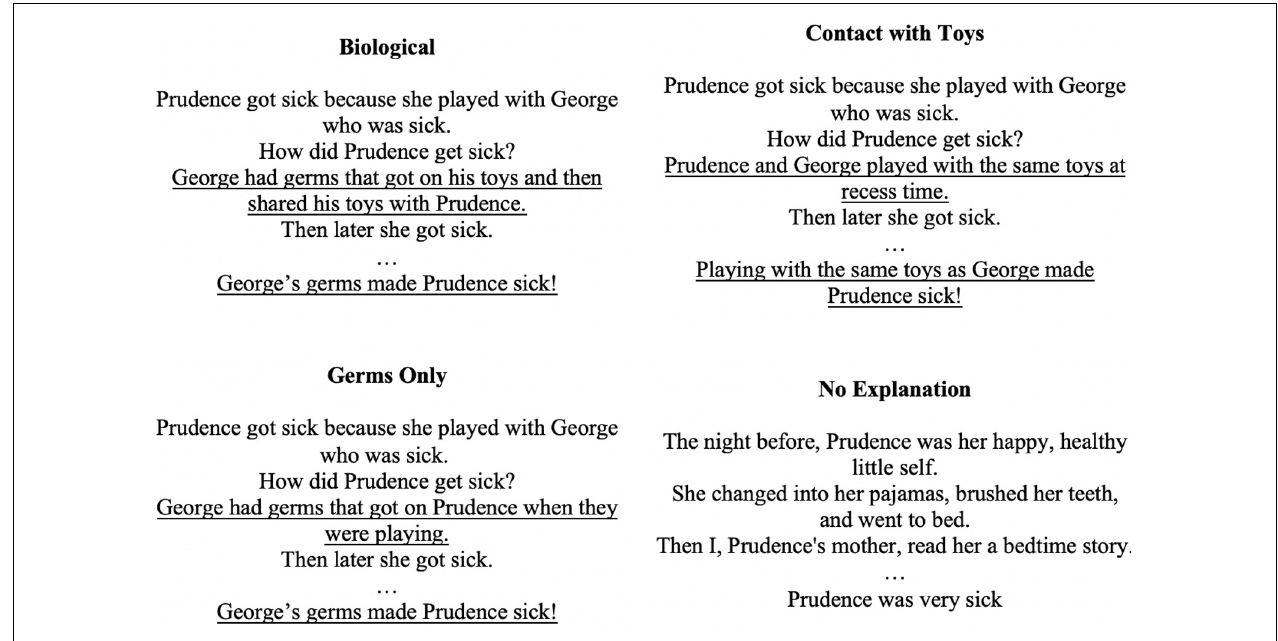
FIGURE 2 | Explanatory text from the four storybooks created for Study